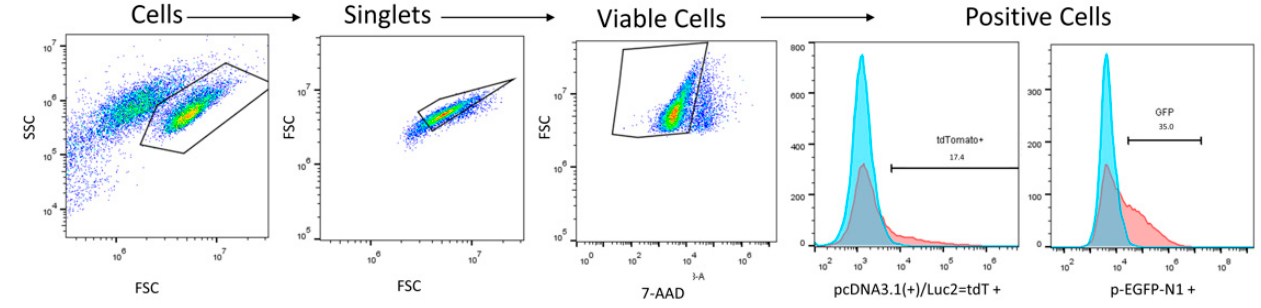
Figure 1. A representative nested gating strategy illustrating transfected cells analysis.